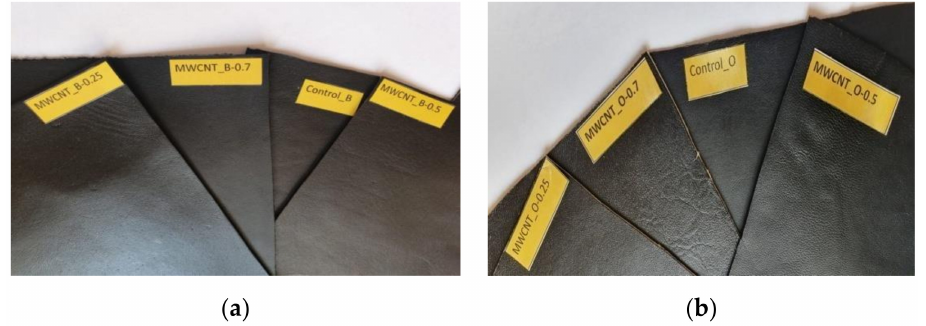
Figure 2. Bovine ( a ) and sheepskin ( b ) leathers treated with MWCNT-based